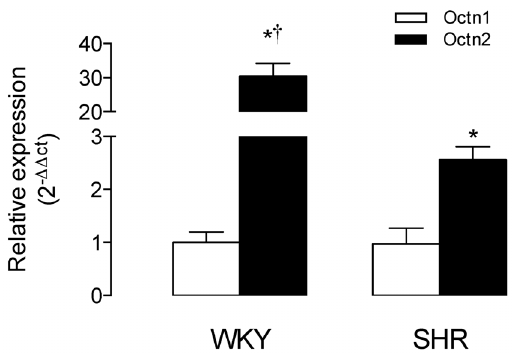
Figure 5. Expression of Octn1 and Octn2. The relative mRNA expression level of Octn1 and Octn2 in RAECs cultures from WKY rats or SHR was estimated from the 2 2 DD CT method using the Light Cycler H 480 SW 1.5 relative quantification (delta-delta-Ct) study software as described in Methods. Gene expression levels were normalized to GAPDH mRNA level. * P , 0.05 versus corresponding values for Octn2. { P , 0.02 versus corresponding values in SHR. Values are mean 6 SEM (n=15).